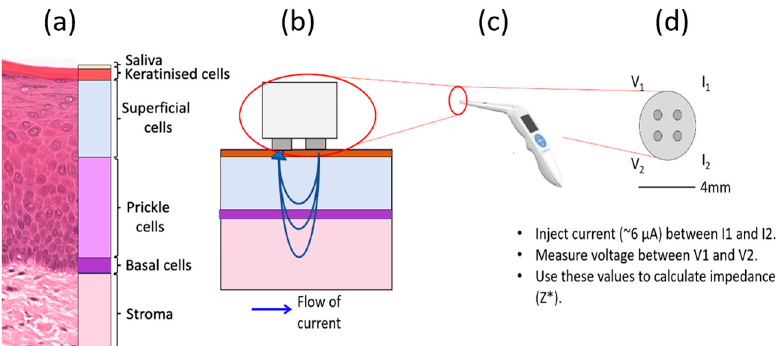
Figure 1. Schematic of a four-point probe EIS measurement of oral tissue. ( a ) Histology image of normal hard palate with cellular compartments annotated. ( b ) The probe tip in contact with oral tissue and the flow of current, ( c ) the ZedScan handset and ( d ) the tetrapolar probe tip with labelled